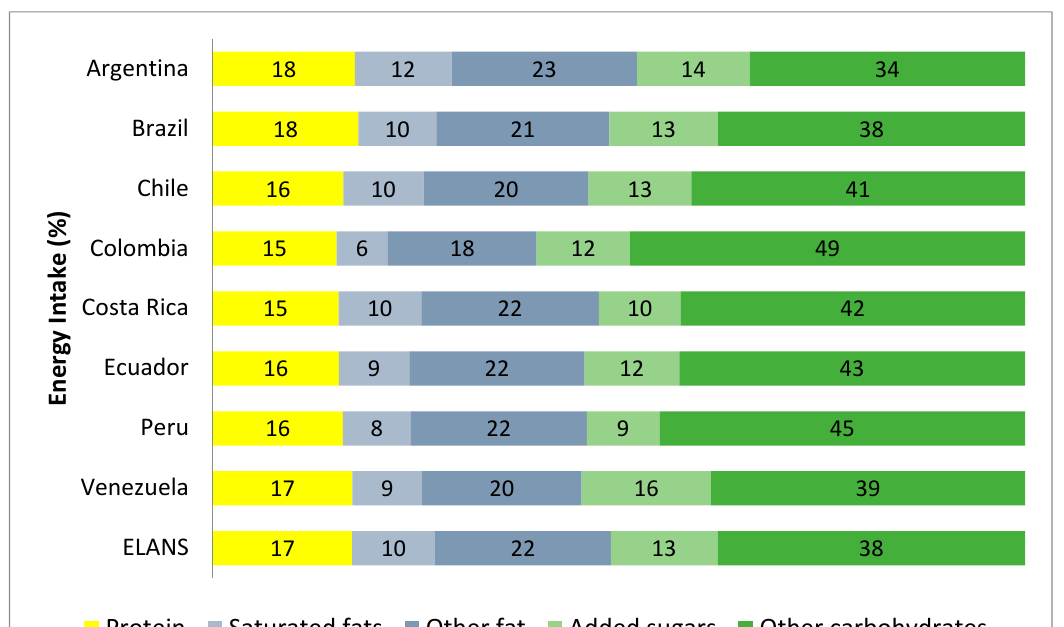
Figure 3. Macronutrient contribution (% energy intake) of breakfast ( A ) relative to the daily intake among occasional and regular breakfast consumers ( B ) and skippers ( C ) by country.